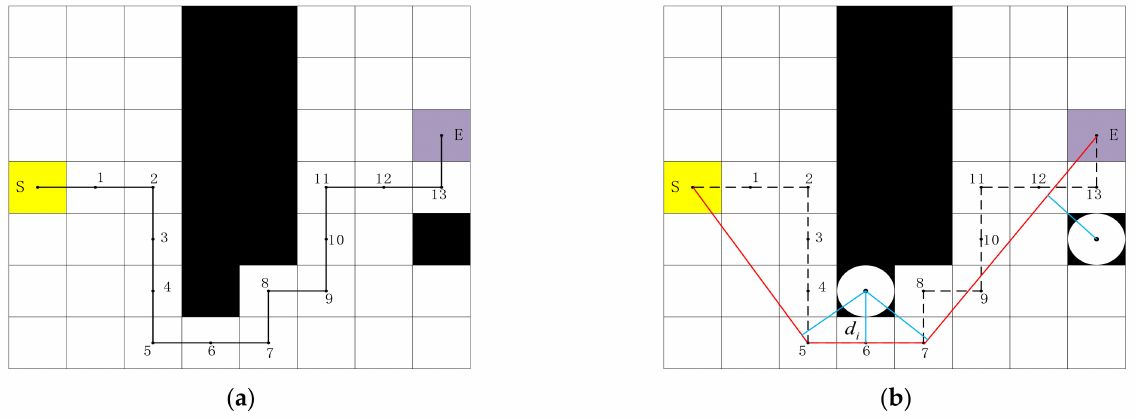
Figure 14. Optimization of path smoothing. ( a ) Smooth pre-optimised path. ( b ) Smooth optimized